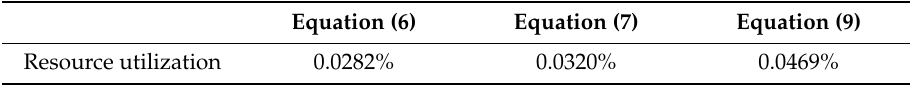
Table 2. Resource utilization of the sigmoid function with di ff erent approximation